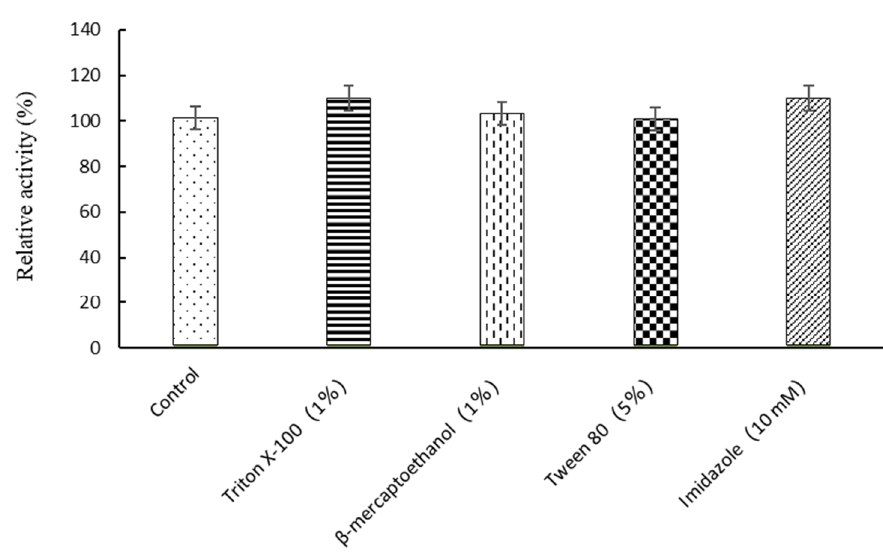
Figure 5. The relative enzymatic activity of SpBGL1 with p NPG as substrate in the presence of Triton X-100, β -mercaptoethanol, Tween 80, or imidazole. The experiments were triplicated, and the error bars represent the standard deviation.